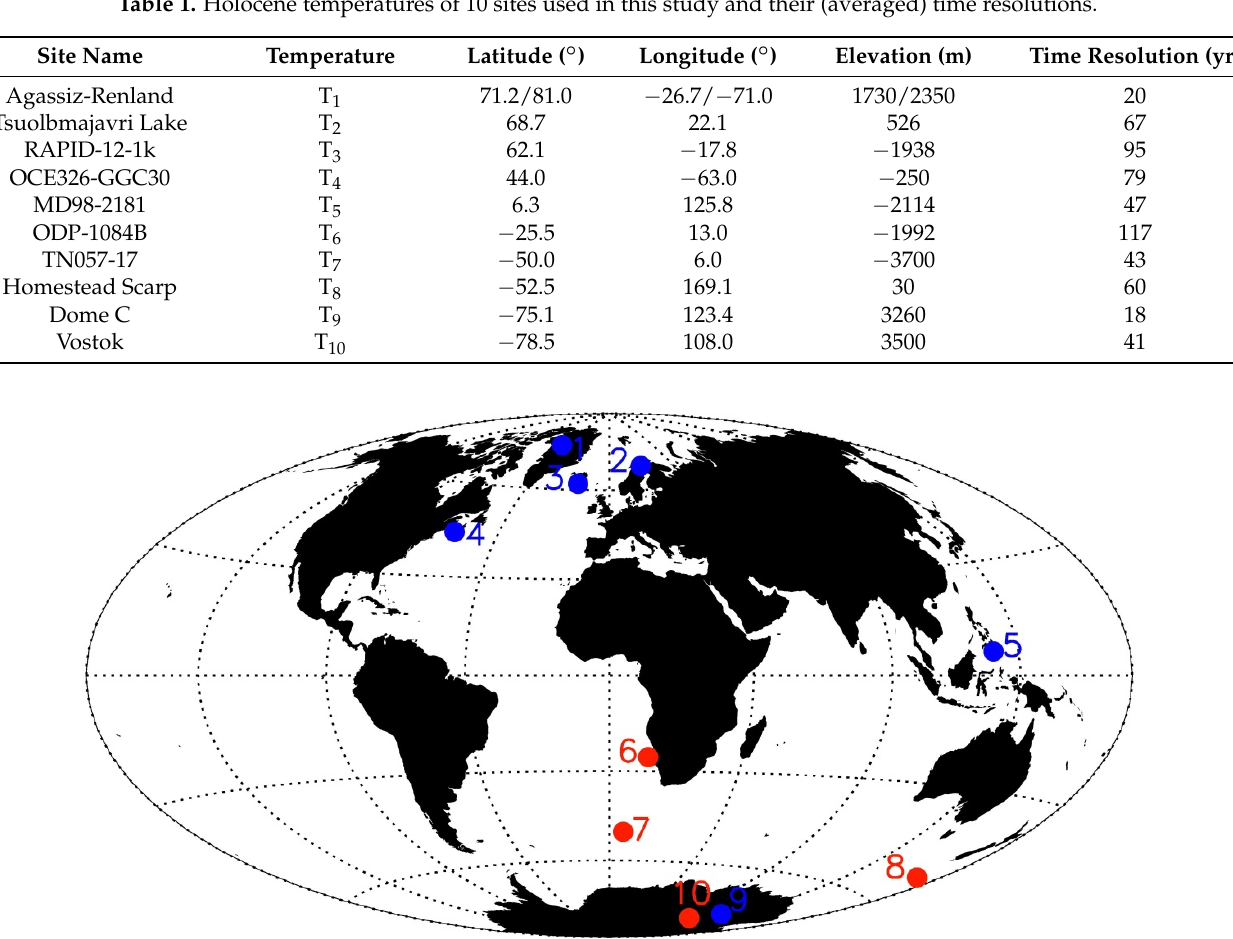
Table 1. Holocene temperatures of 10 sites used in this study and their (averaged) time resolutions.